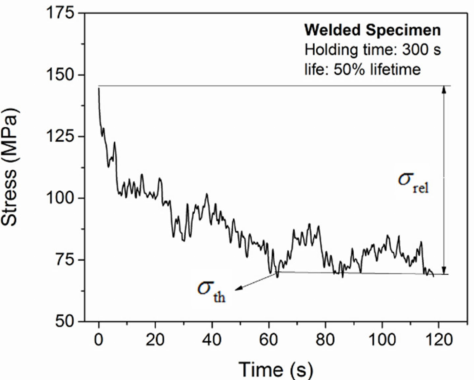
Figure 8. Typical stress relaxation curves of the welded specimen with a holding time of 300 s at 50% of the lifetime fraction.